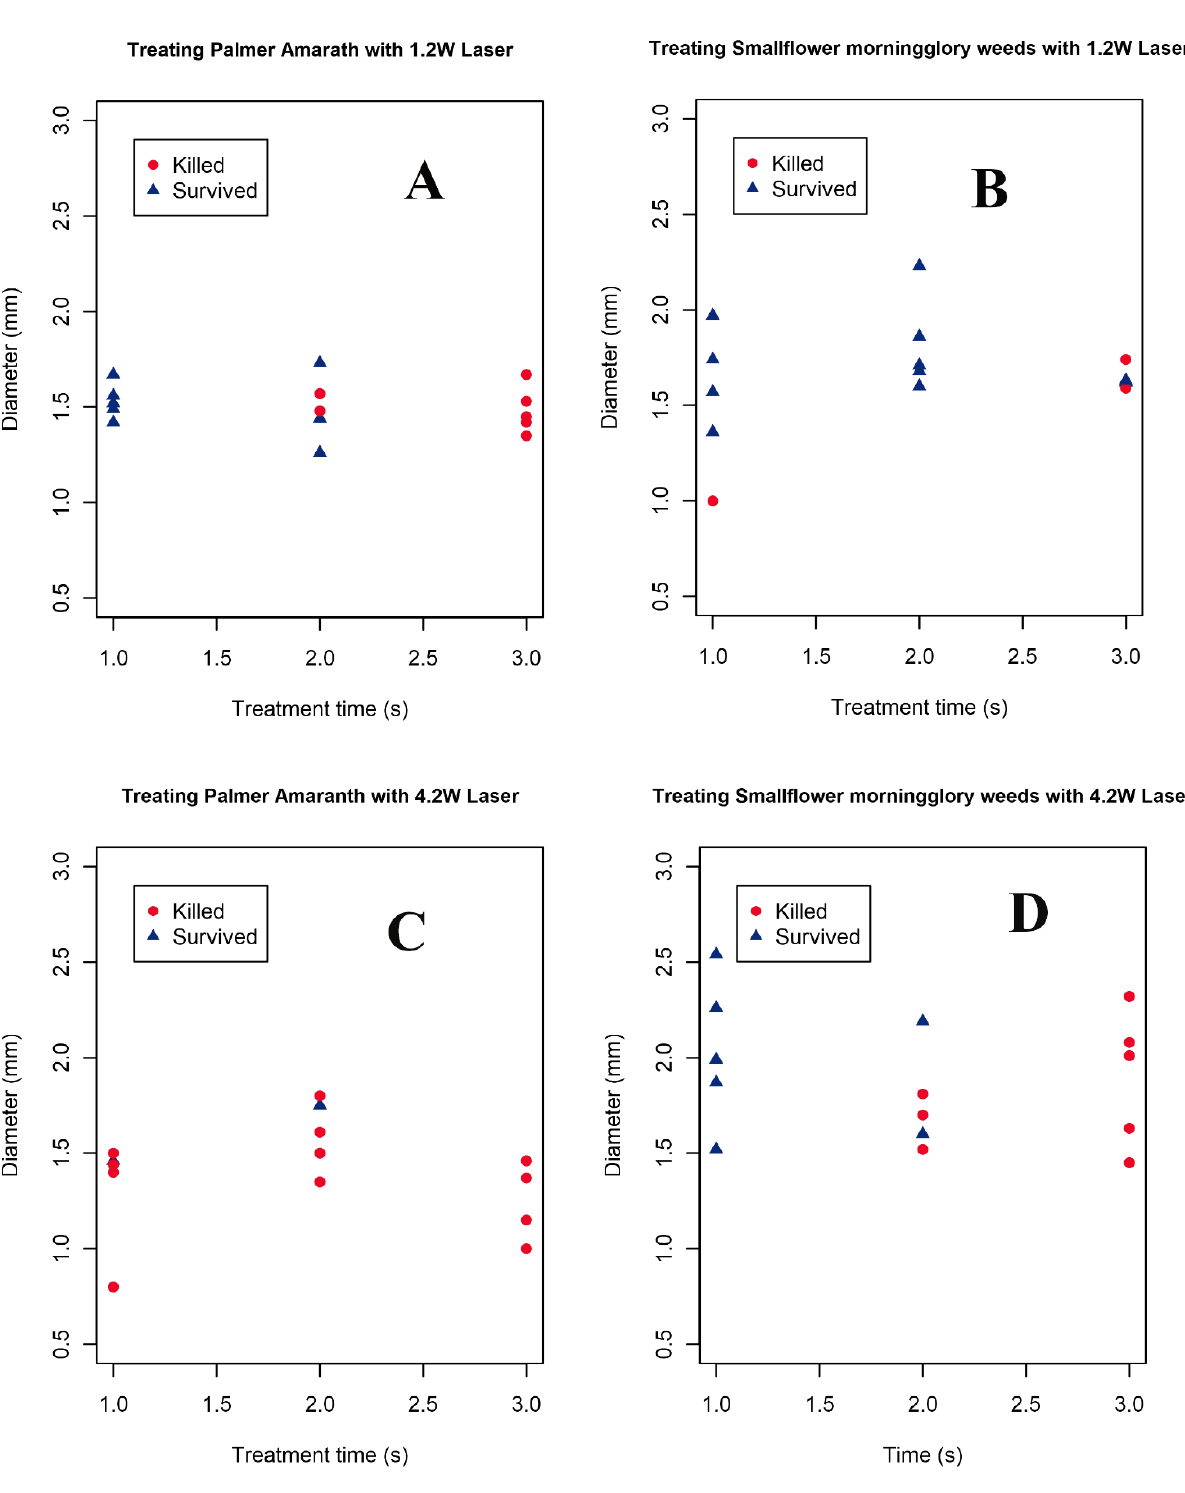
Figure 7. Status of weeds after 1 week of monitoring. ( A ) using 1.2 W laser on Palmer amaranth, ( B ) using 1.2 W laser on smallflower morningglory, ( C ) using 4.2 W laser on Palmer amaranth, ( D ) using 4.2 W laser on smallflower morningglory.